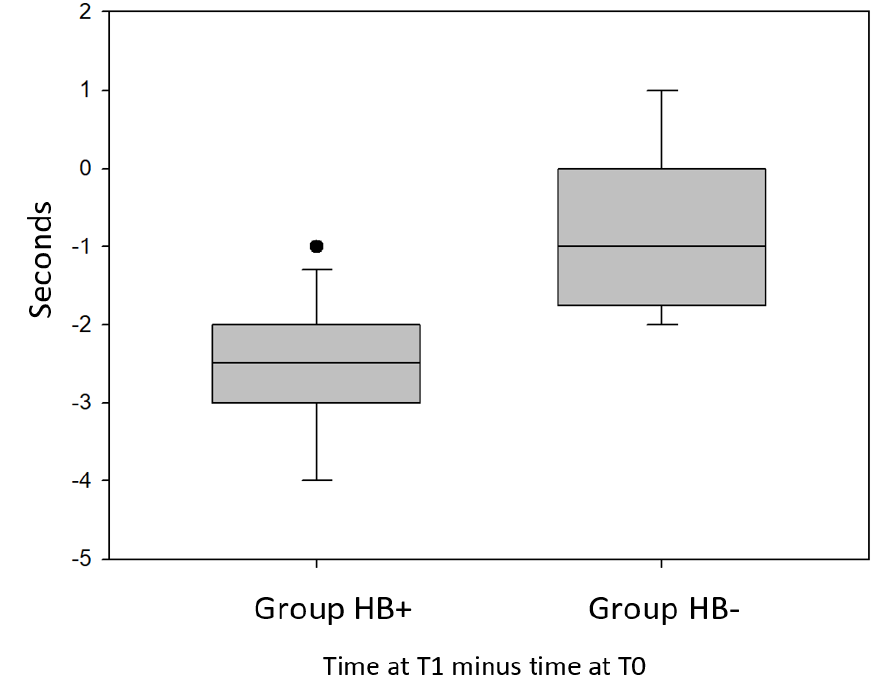
Figure 5. Difference in recorded times between T1 and T0 of the Hb+ group compared with the same ff erence measured in Hb- group with balance beam walking test difference measured in Hb- group with balance beam walking test (BBWT). di